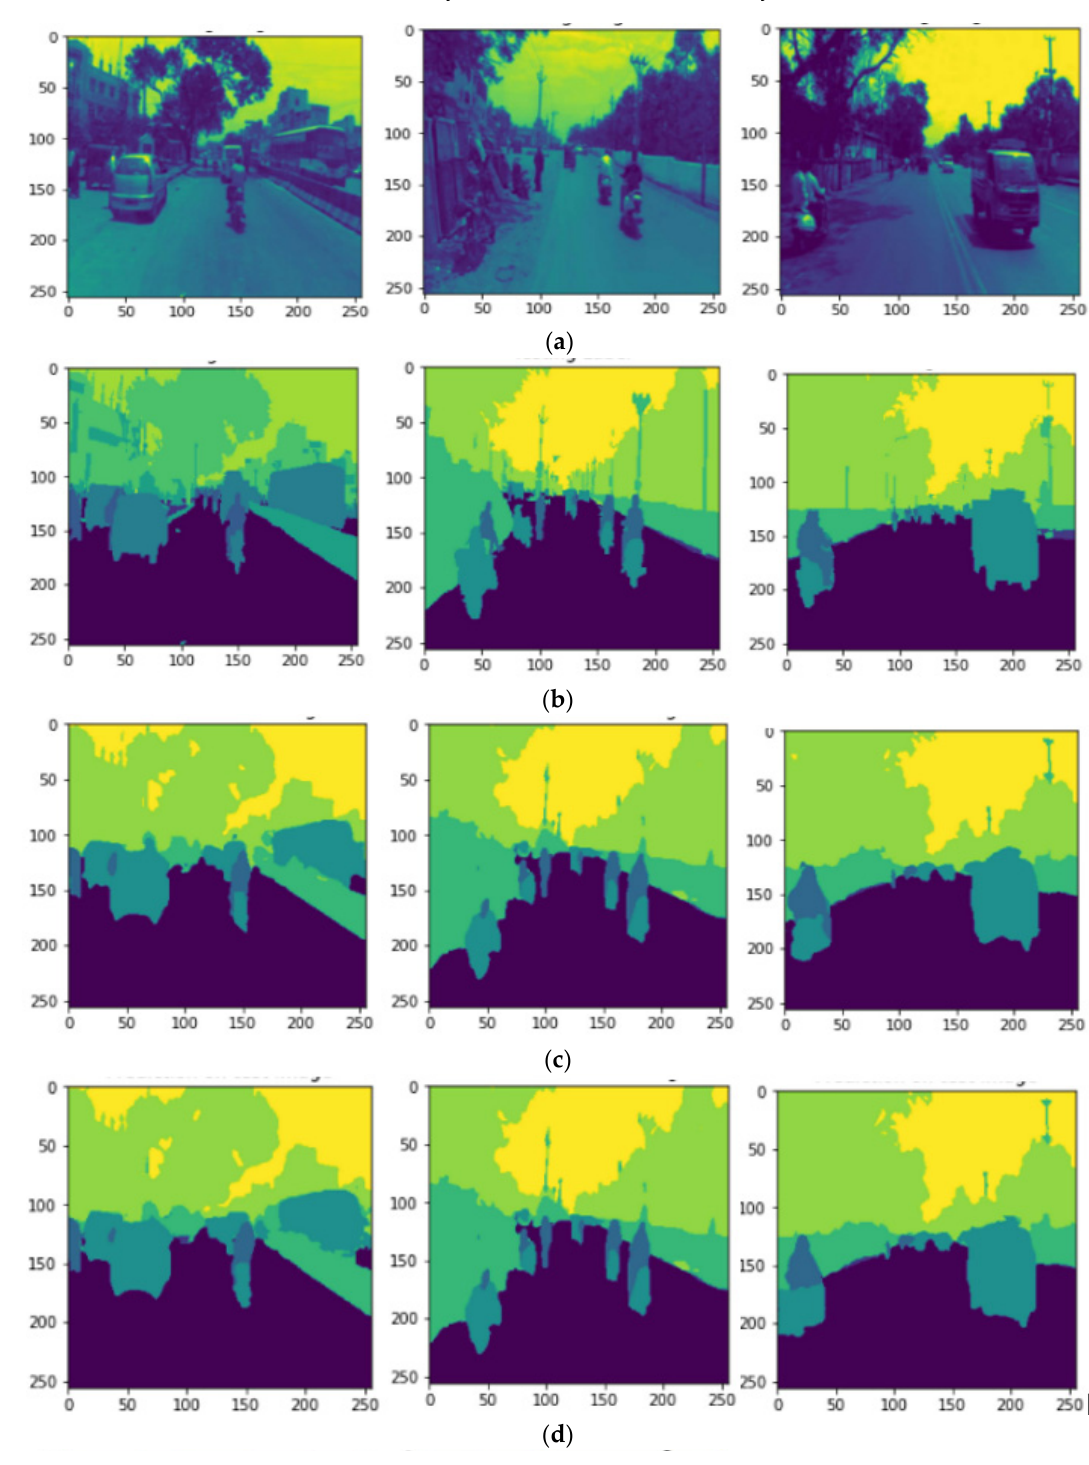
10 of 14 Table 5. IoU Value and F1 score obtained by the ensembled Segmentation Models . Class/Model